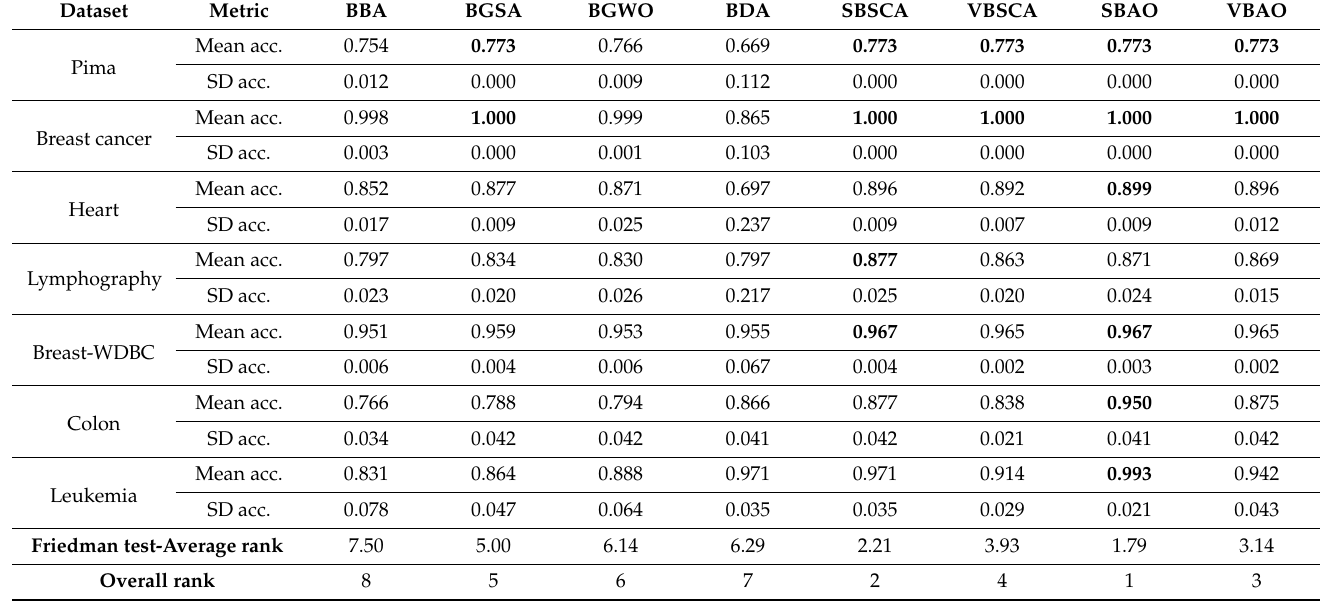
Table 7. The accuracy comparison of SBAO and VBAO with other binary metaheuristic algorithms.